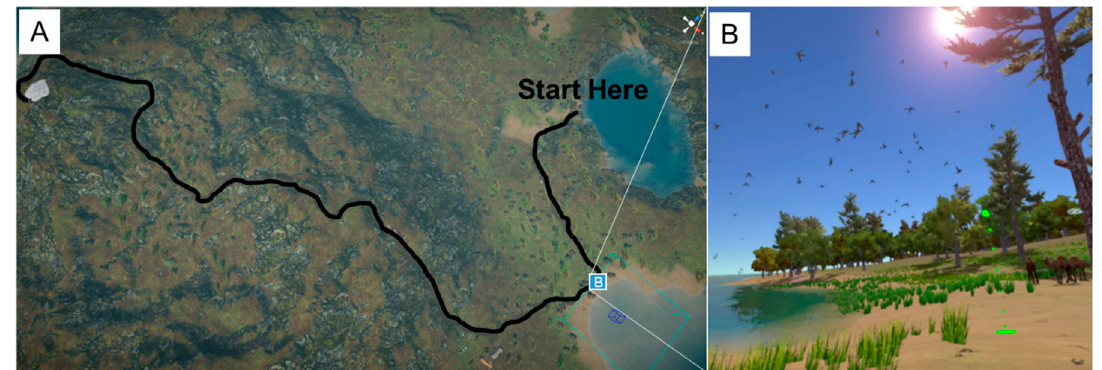
Figure 4. iVR Zoo navigation. ( A ) Participants in the iVR Zoo condition were instructed to follow a path since all animal items to be learned could be seen while navigating this path. ( B ) To navigate more quickly across the island, participants used the teleport function via their left handset: when participants clicked on the top button, they could see a green arc indicating the trajectory of where they would land.